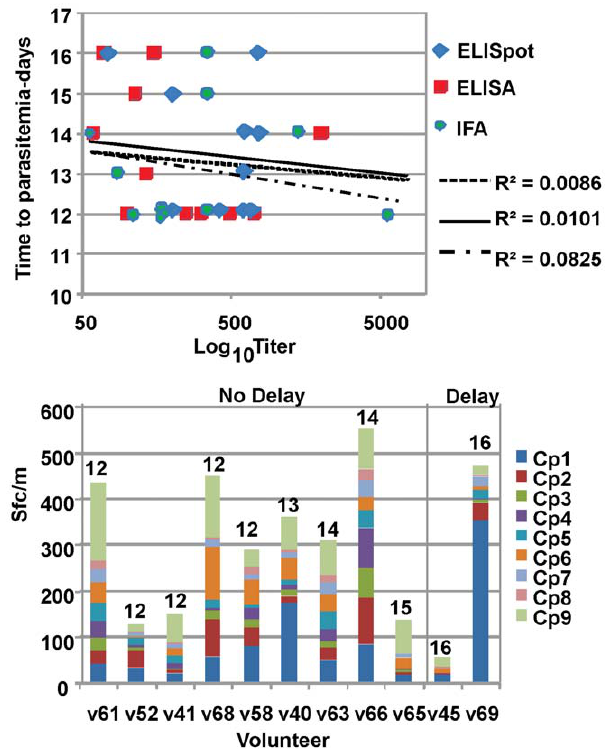
Figure 12. Relationship between pre-challenge ELISA (CSP), IFA (sporozoite) and ELISpot (CSP) activities and time to patency after challenge. Upper Panel: The time to patency in days after sporozoite challenge was compared to the pre-challenge magnitude of three immune measures: ELISA (CSP), IFA (sporozoite) and ELISpot (CSP). Best-fit trendlines are plotted with r 2 values shown. There was no correlation between immune measures and time to patency. Lower Panel: Volunteers are arrayed according to time to patency (labeled in days at the top of each column), showing ELISpot activity to each color-coded CSP peptide pool. There is no evident relationship between magnitude of pool-specific or summed responses and time to